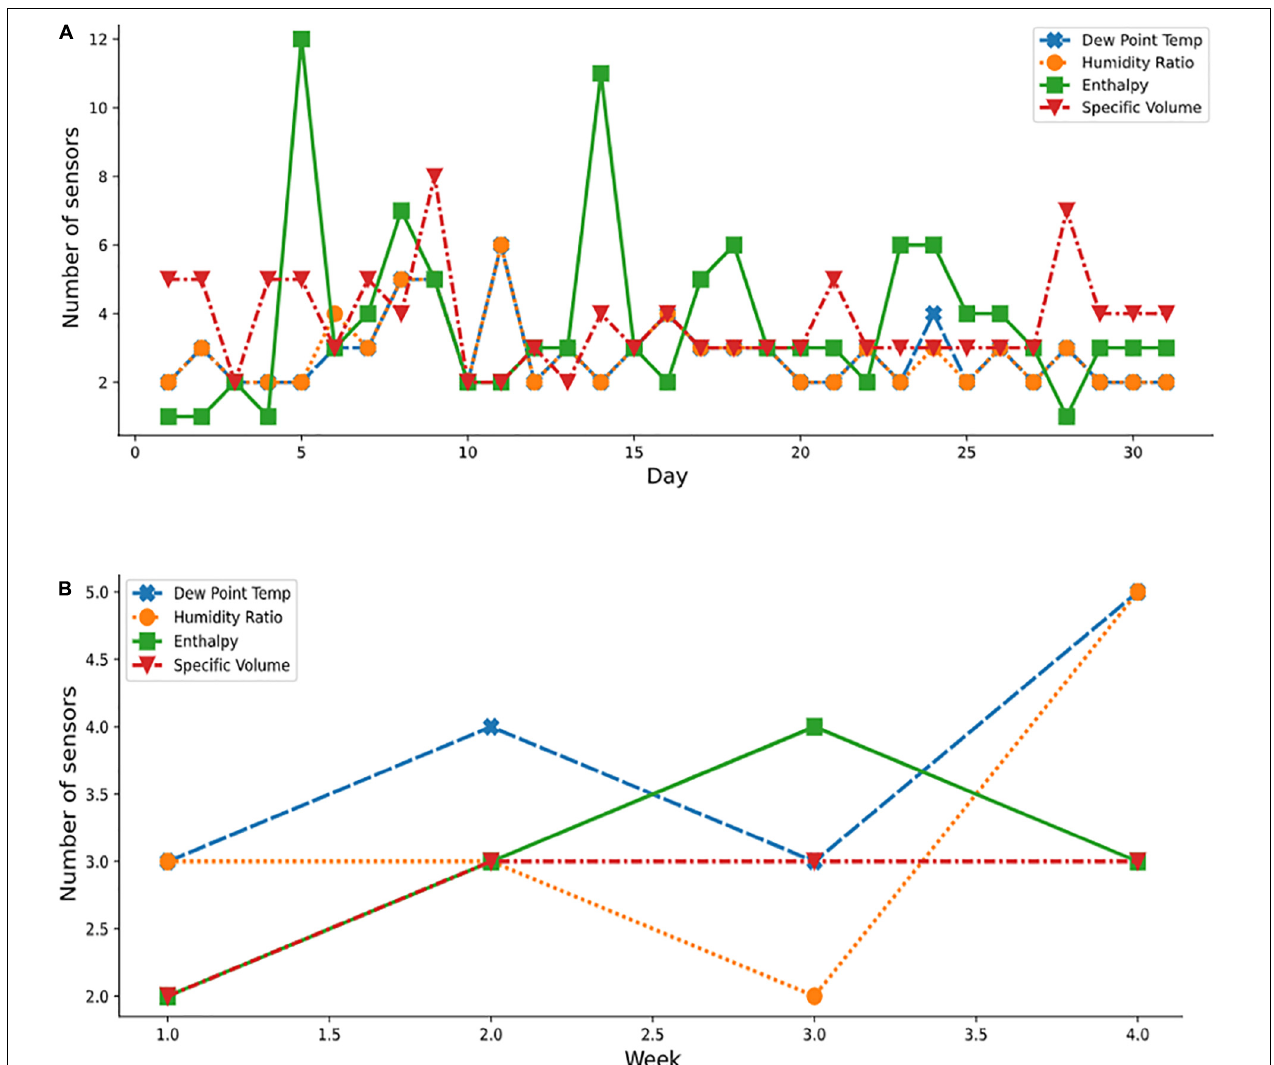
FIGURE 11 | Optimal sensor selection for Autumn month using the psychometric dataset; (A) October daily; and (B)